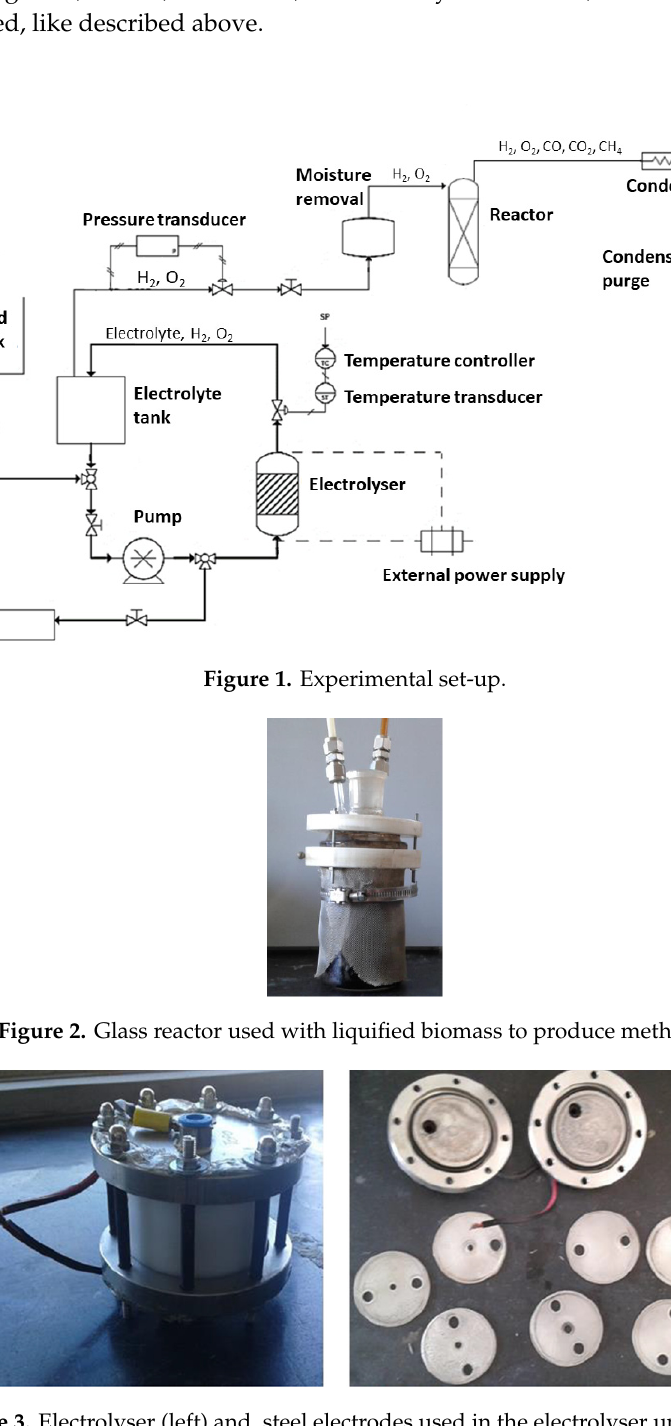
Figure 3. Electrolyser (left) and, steel electrodes used in the electrolyser unit (right).